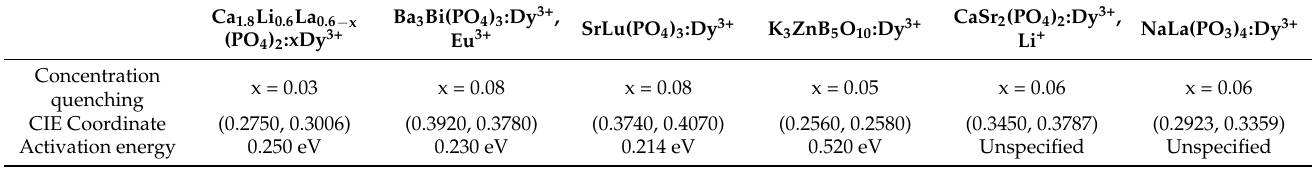
Table 4. Comparison of the results of this article with the other